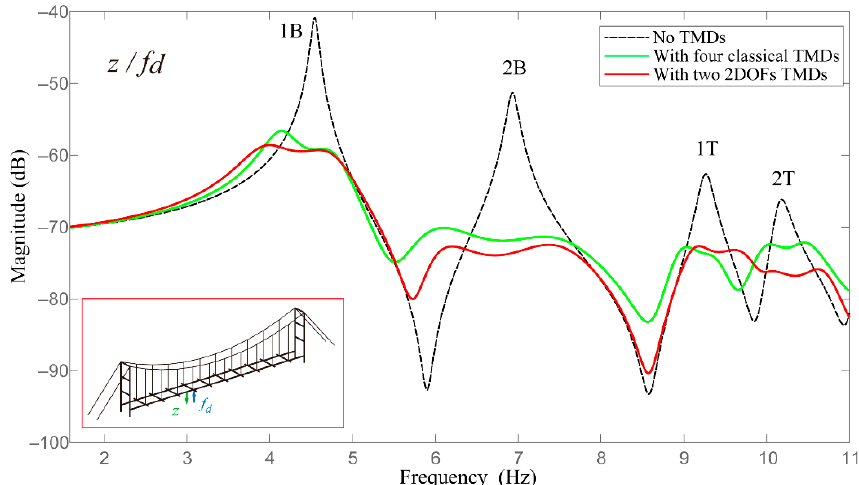
Figure 3. Numerical results: FRFs of the deck without and with the TMDs. The TMDs are targeted for the damping of the mode pair (2B,1T) and (1B,2T).